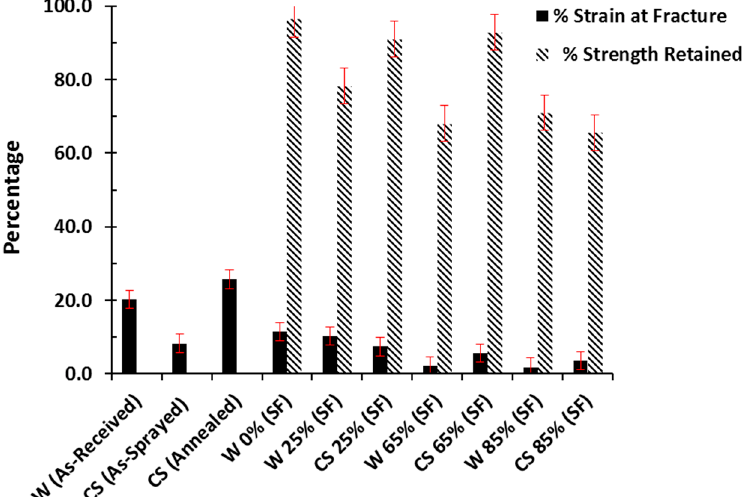
Figure 11. Strain at fracture and strength retained of wrought (W) and cold-sprayed (CS) samples at various pre-stress levels after 90 days of B-117 salt fog exposure (SF).